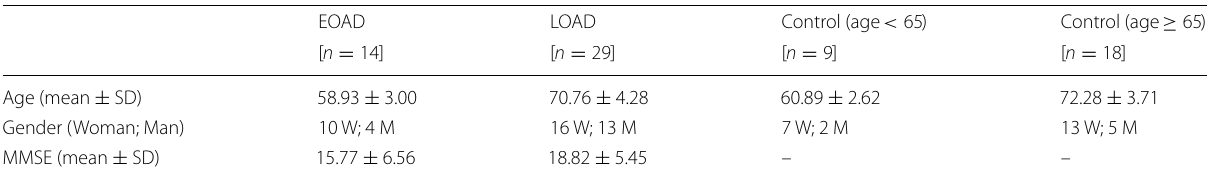
Table 1 Overview of the subjects included in the study